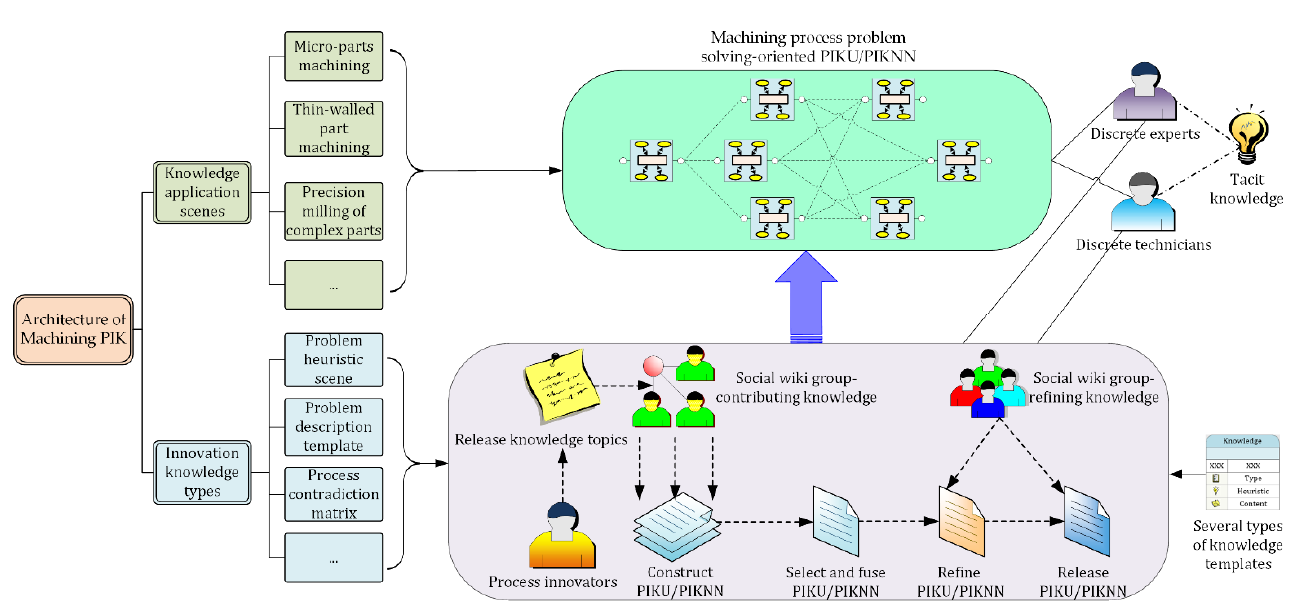
Figure 3. Open knowledge acquisition paradigm for machining process